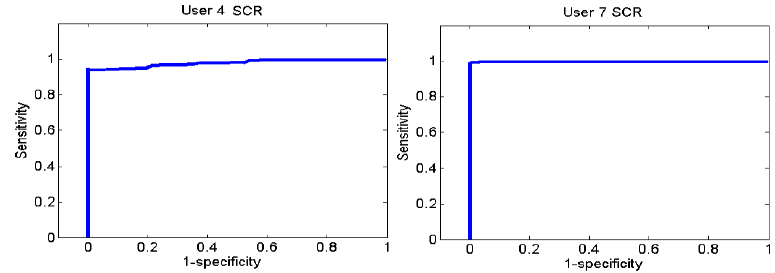
Figure 26. ROC curve of users 4 and 7 from the Stoop Test.